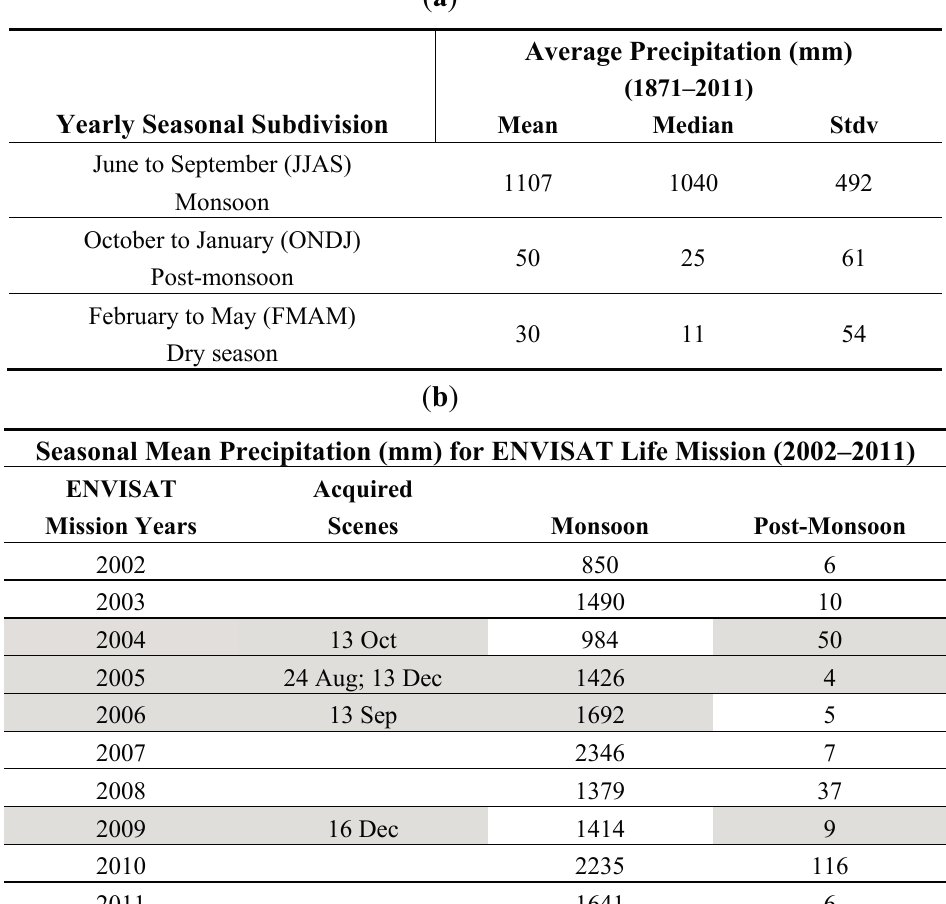
Table 1. Climatic subdivision (after Balbo et al. [14]) and average seasonal rainfall from Kachchh-Saurashtra region (data from Indian Institute of Tropical Meteorology,